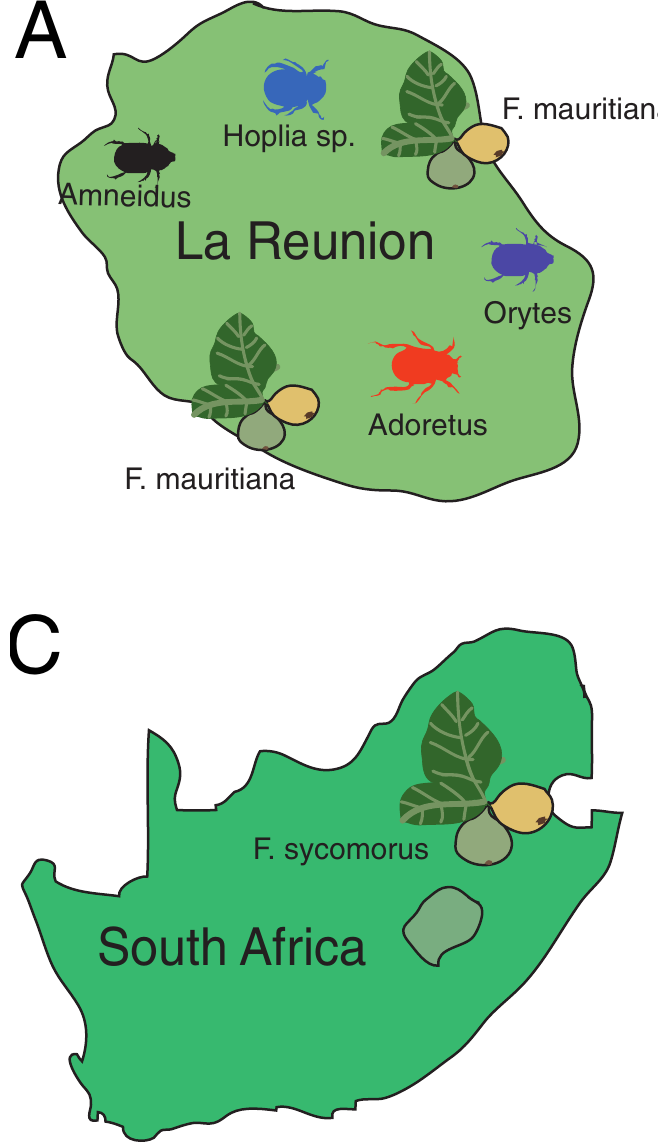
PLOS ONE | https://doi.org/10.1371/journal.pone.0198018 June 4,